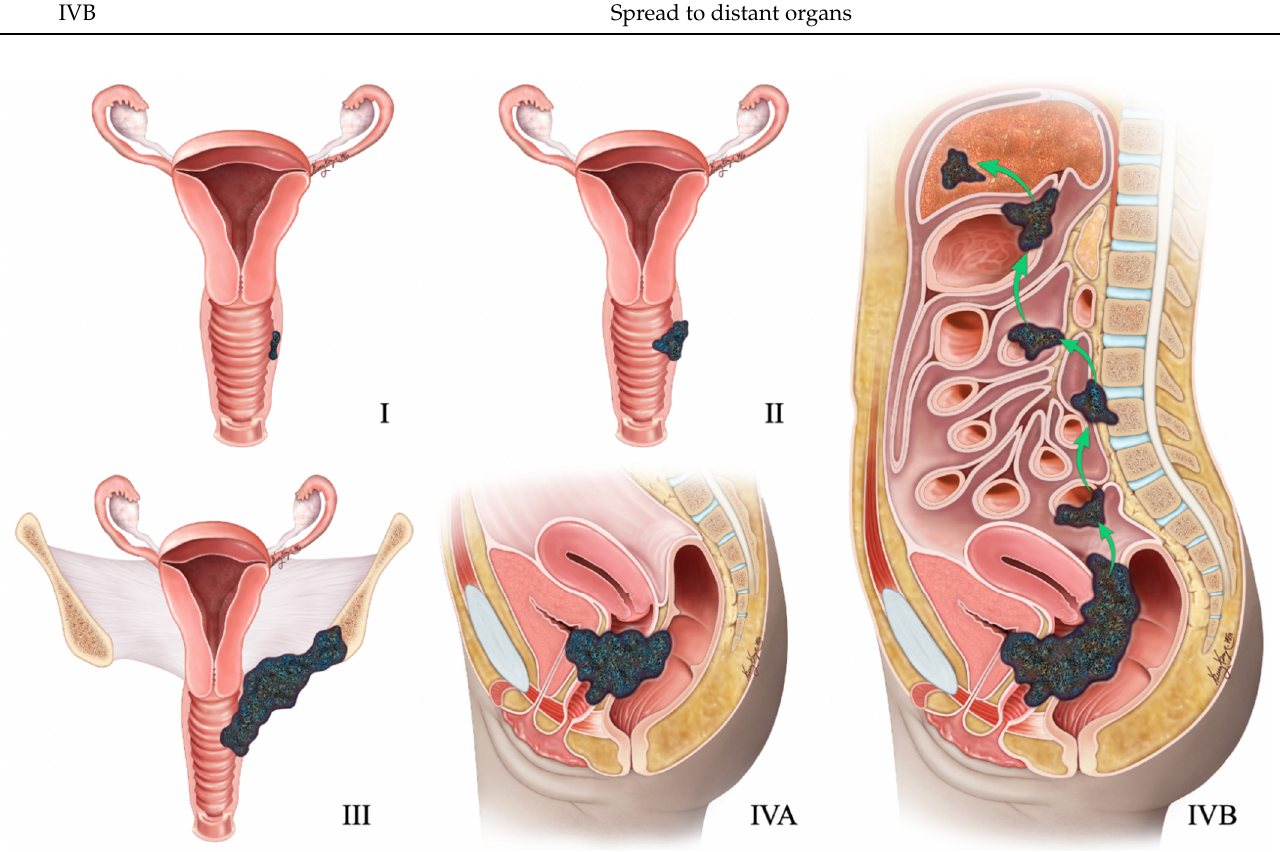
Figure 14. FIGO Staging of vaginal tumors. Stage I is limited to the vaginal wall. Stage II is beyond the vaginal wall without pelvic sidewall involvement. Stage III extends to the pelvic sidewall. Stage IVA infiltrates bladder or rectum or the tumor extending beyond the pelvis, with any nodal metastasis. Stage IVB has distant metastasis. Table 12. American Joint Committee on Cancer (AJCC) staging of vaginal